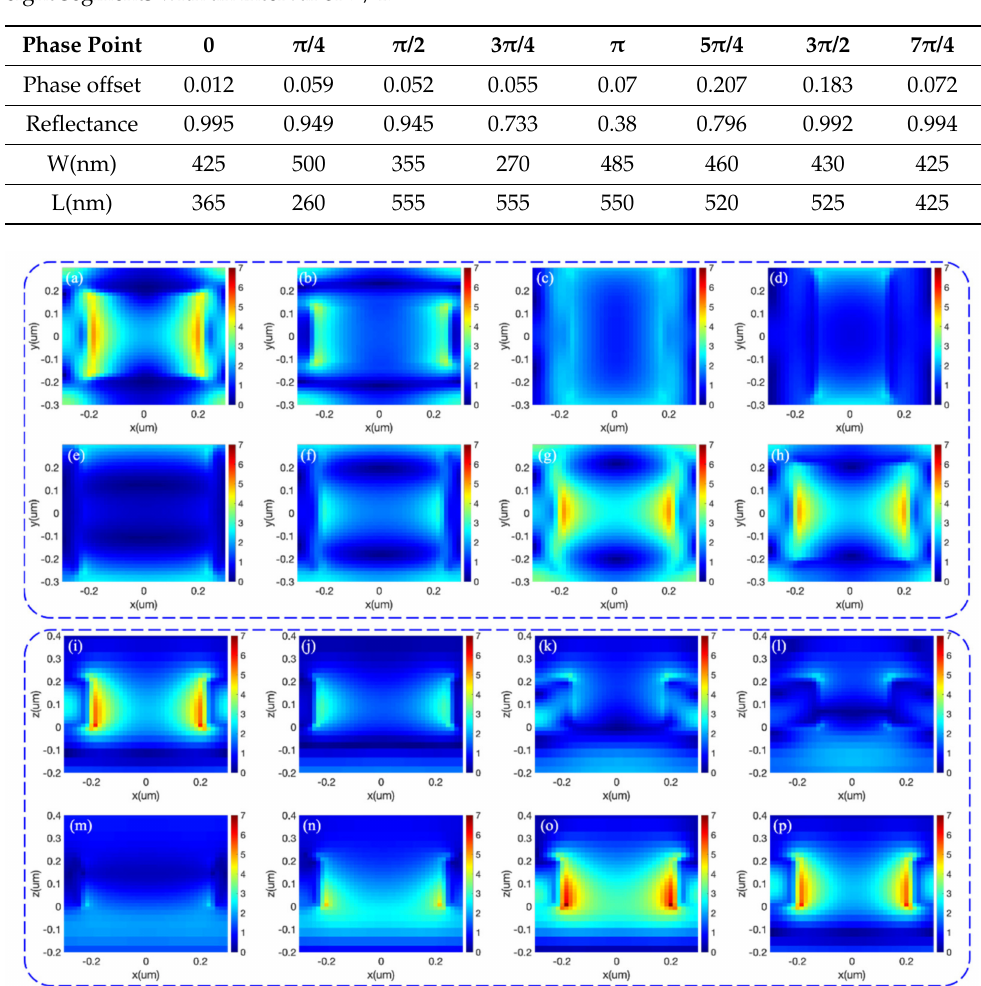
Figure 3. Electric field distributions of the 8 selected unit-cells: ( a – h ) normalized electric field distribution on the x-y plane with z = 100 nm; ( i – p ) normalized electric field distribution on the x-z plane with y =